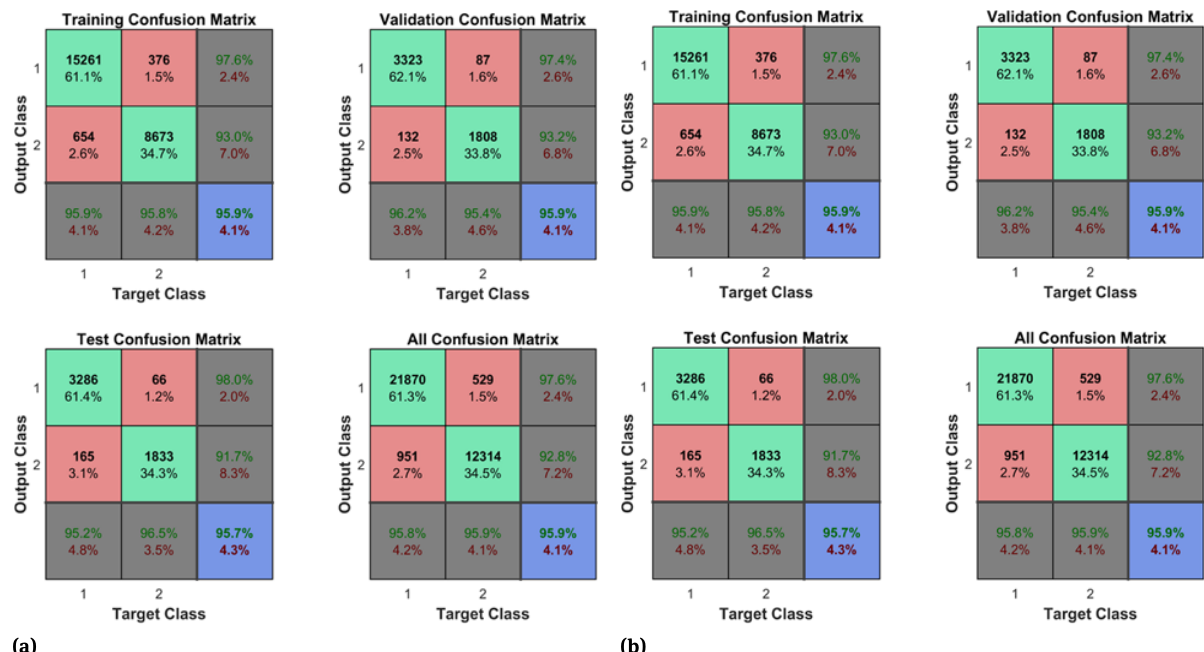
Figure 4: The confusion matrix for Group 6 of (a) LM and (b) SCG training